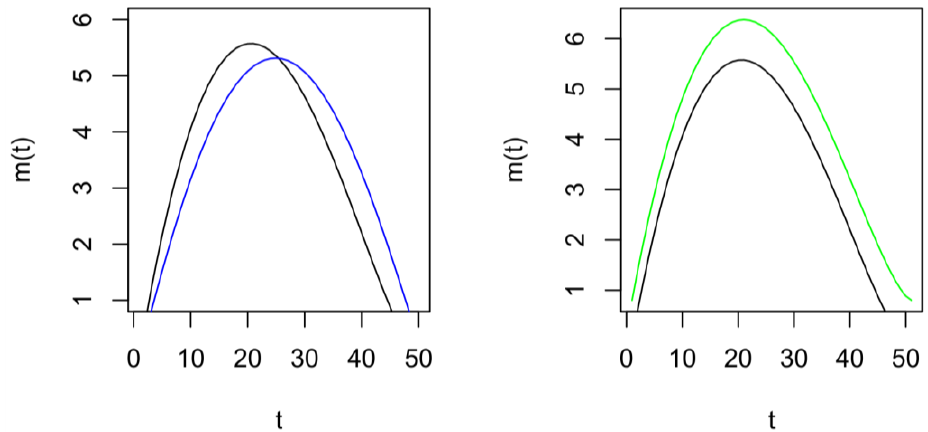
Figure 2. ( Left panel ): Variation in shape. ( Right panel ): Variation in magnitude.